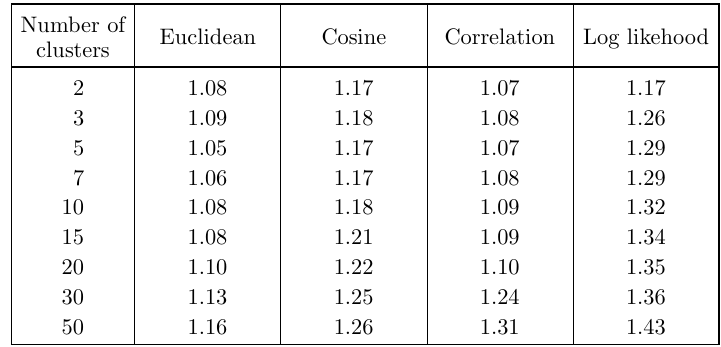
Evaluation ( RMSE ) of recommendation system based on k-means clustering algorithm and the average ratings approach to representative values of